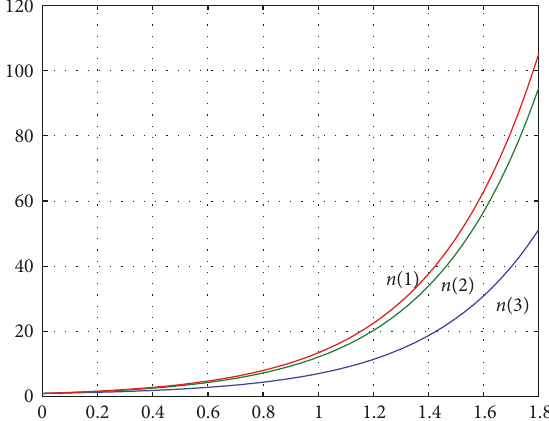
Figure 8: Evolution curve of variables when the initial state set as [1, 1,1]